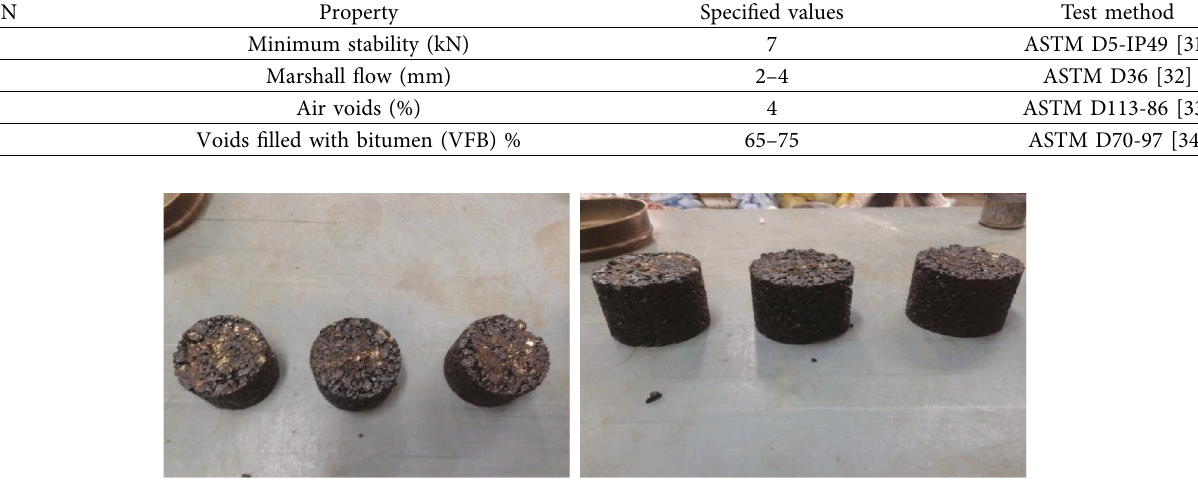
Figure 1: Prepared Marshall